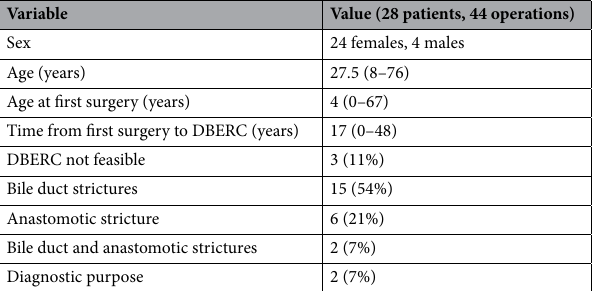
Table 1. Characteristics of patients who underwent double-balloon endoscopic retrograde cholangiography (DBERC) between 2011 and 2019 in our facility. Data are presented as the median (range) or number